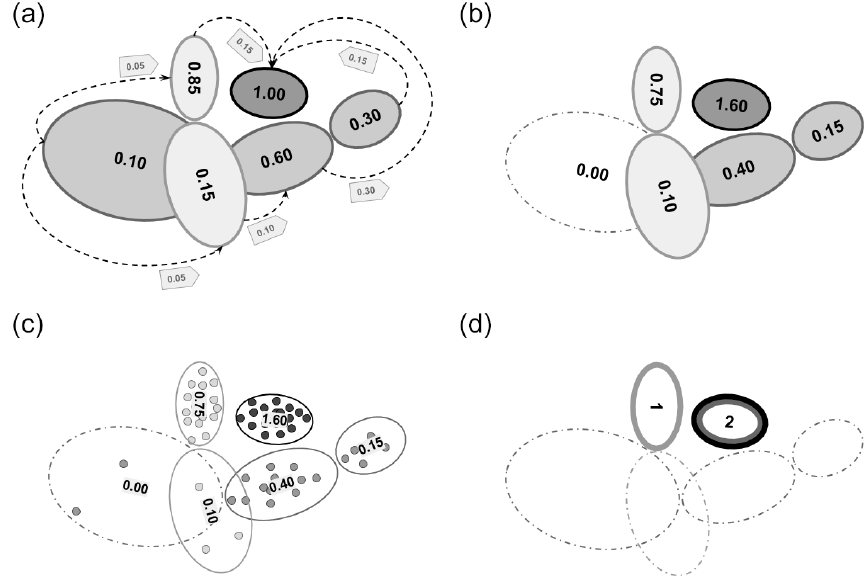
Figure 8. Idealized schematic representations of three events with one, two and three Gaussian kernels each. (a) Condensation: each event is represented by a different shade, weight transfer is represented by the arrows; notice that there are no intra-event weight transfers. (b) Final condensed catalog: the total weight sum is preserved, one component is discarded. (c) Sampling of the event PDFs: this step is done on the original catalog. (d) Each event is assigned to the condensed kernel that provides the maximum likelihood for most of its sampled points; three events are assigned to two condensed kernels.